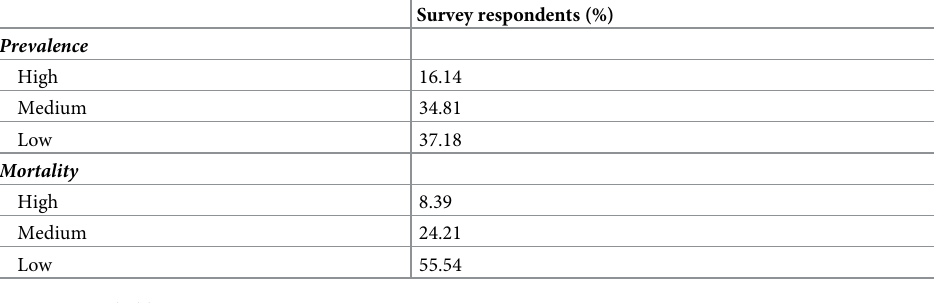
Table 5. Perceived tsetse infestation and severity of